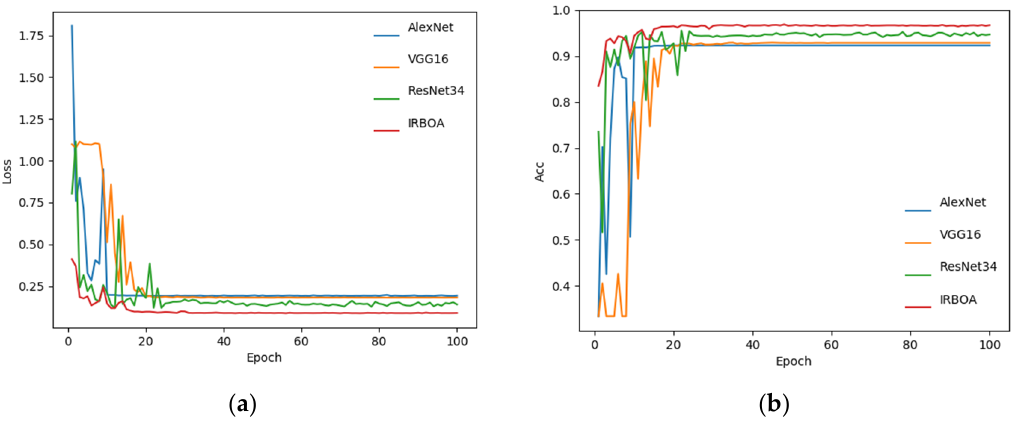
Figure 6. Comparison of the learning curves of the four CNN models. ( a ) Loss curve. ( b ) Accuracy curve.